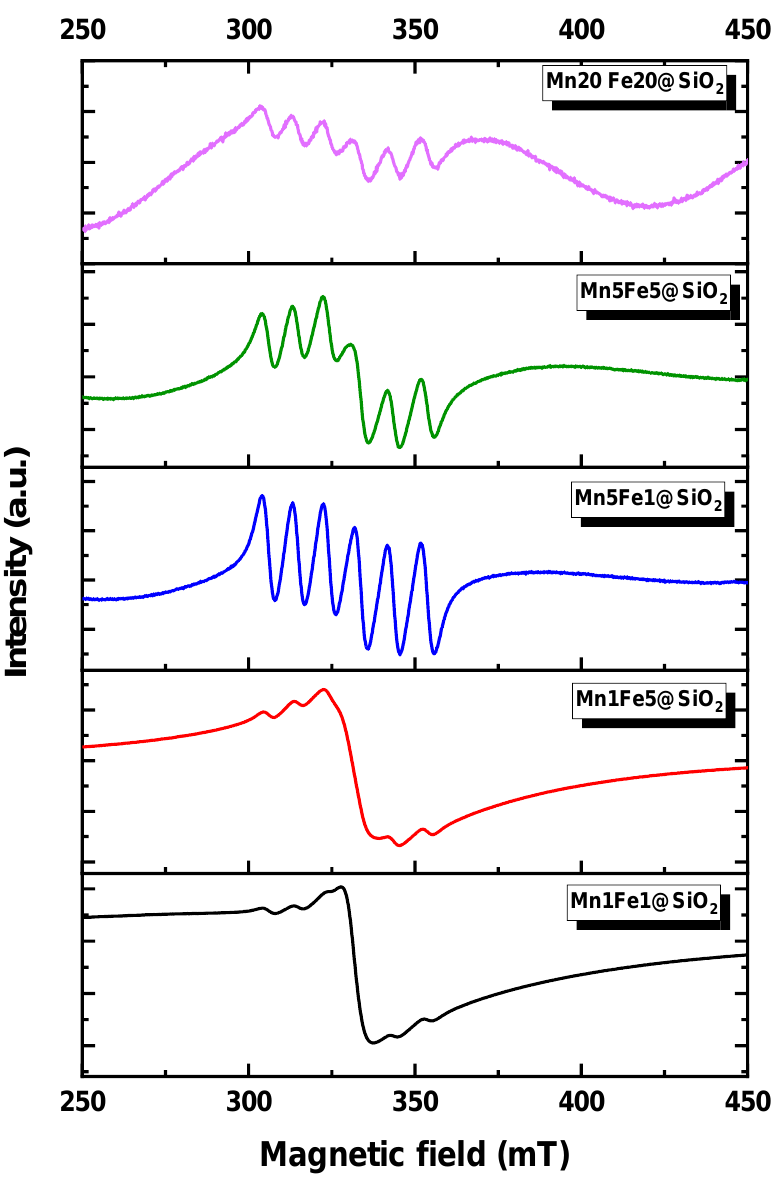
Figure 7. ESR spectra recorded at 298 K.